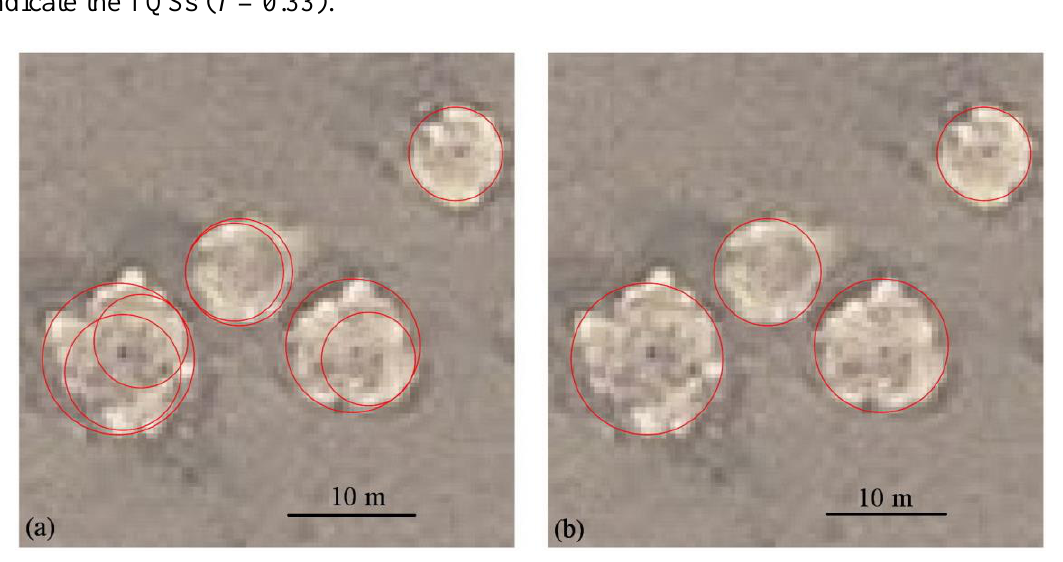
Figure 6. False extractions removed in the test image from the red box in Figure 4b. ( a ) Preliminary extractions of TQSs. ( b ) Revised extractions with 𝜌 , Δ C , and Δ R . Red circles indicate the TQSs ( T =